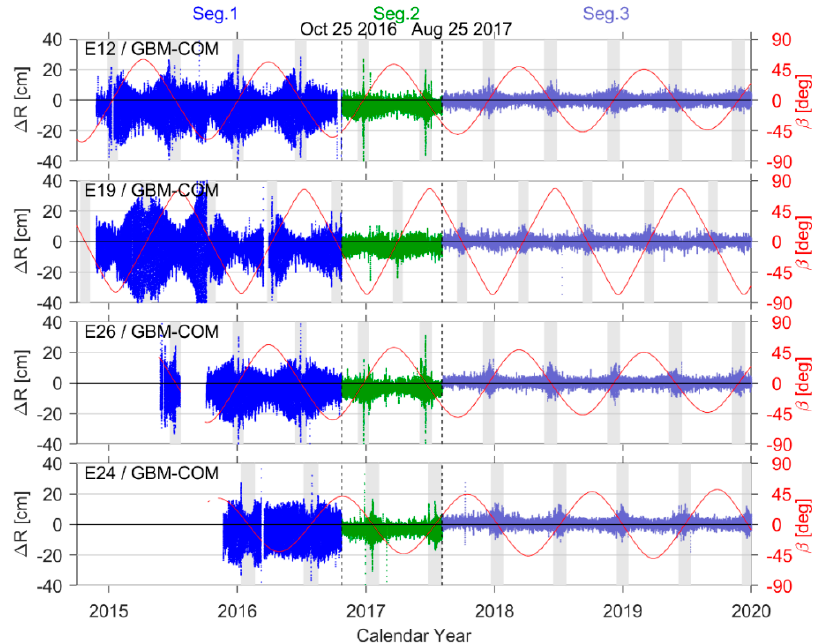
Figure 8. A COM-GBM orbit comparison in the radial direction.